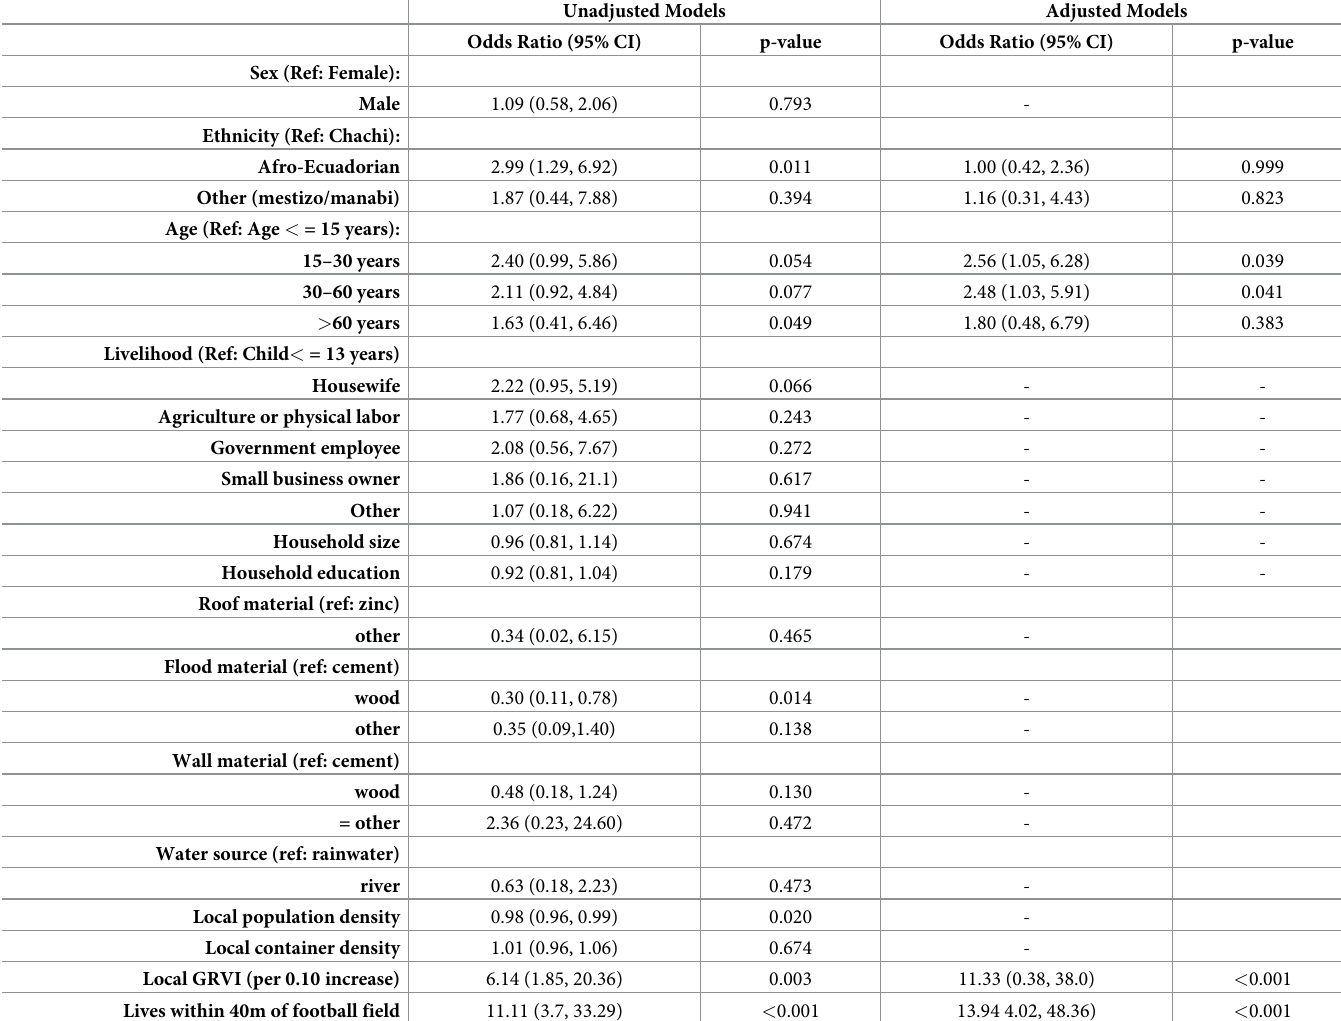
Table 3. Mixed Effect Logistic Regression: Factors associated with case status. Risk factors for symptomatic dengue based on bivariable and multivariable mixed-effect logistic regression models. Unadjusted Models Adjusted